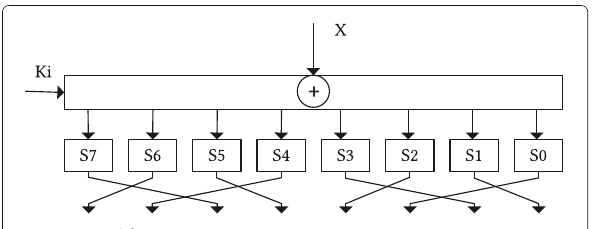
Fig. 4 Round function F